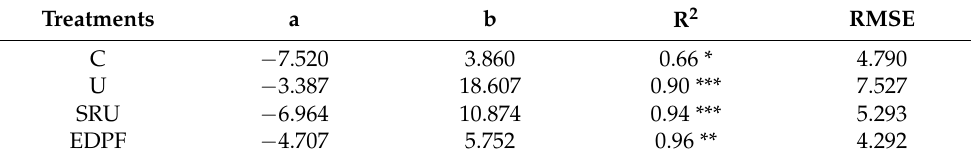
Table 6. Release kinetic of NH 3 volatilization under different fertilization treatments.